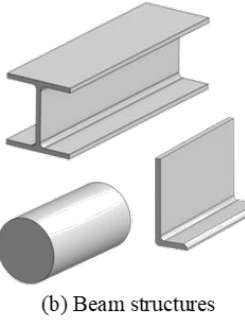
Figure 6. Data size minimization for the same type part.